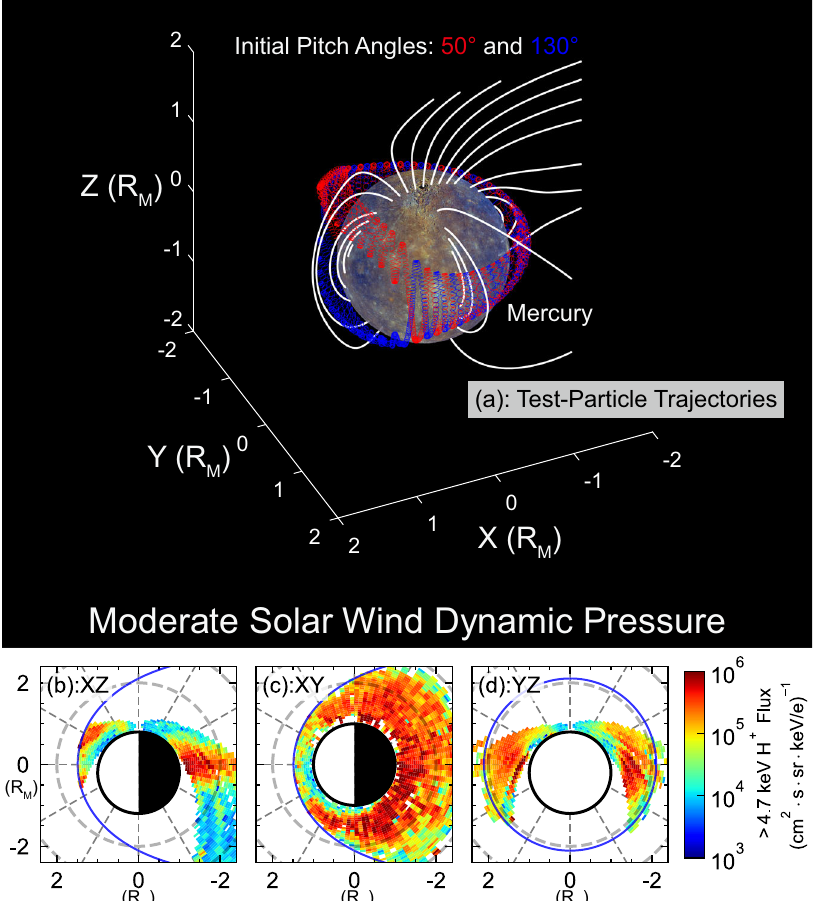
Fig. 3 Comparison of the test-particle simulation and MESSENGER observations of Mercury ’ s off-equatorial ring current. a 3D view of the trajectories of the 5 keV test protons shown by the red and blue curves with magnetic fi eld lines shown by the white curves. The model parameters r Hel and DI are 0.387 AU and 50, respectively, corresponding to a R of 1.41 R . b – d Energetic proton fl ux distributions based on MESSENGER observations in the day- SS M night (Local Time: 11 – 13 h & 23 – 01 h), geomagnetic equatorial (| Z |<0.2 R M ), and dawn-dusk planes (Local Time: 5 – 7 h & 17 – 19 h) under moderate solar wind p dyn (1 : 35 R M < R SS < 1 : 49 R M ). The dashed grey circles indicate the gridlines with radius of 2 R M . See Supplementary Fig. 9 for the colour alternative version of this fi